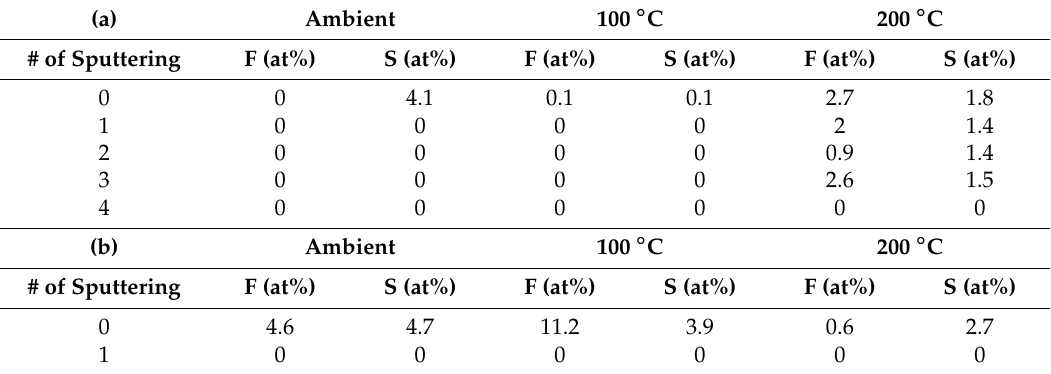
Table 3. The XPS data on the non-contact area: ( a ) Crystalline Pd and ( b ) amorphous Pd